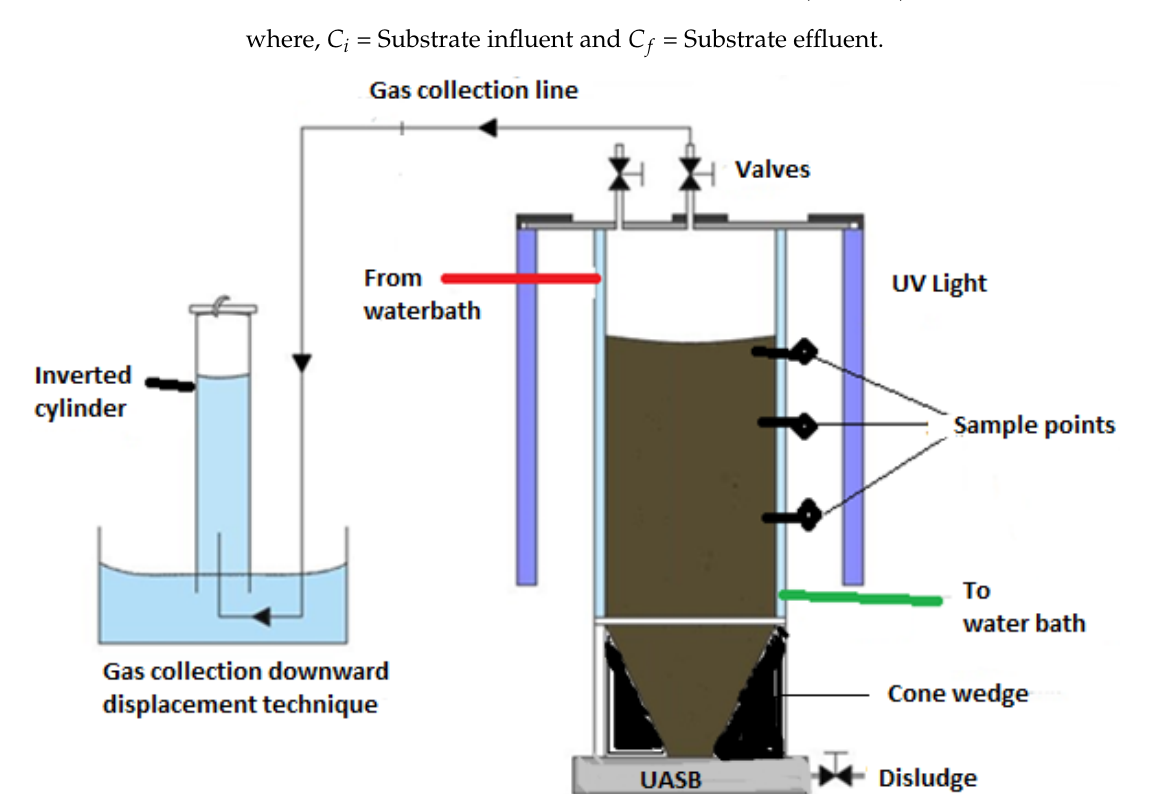
Figure 2. Schematic presentation of the biophotocatalytic system.